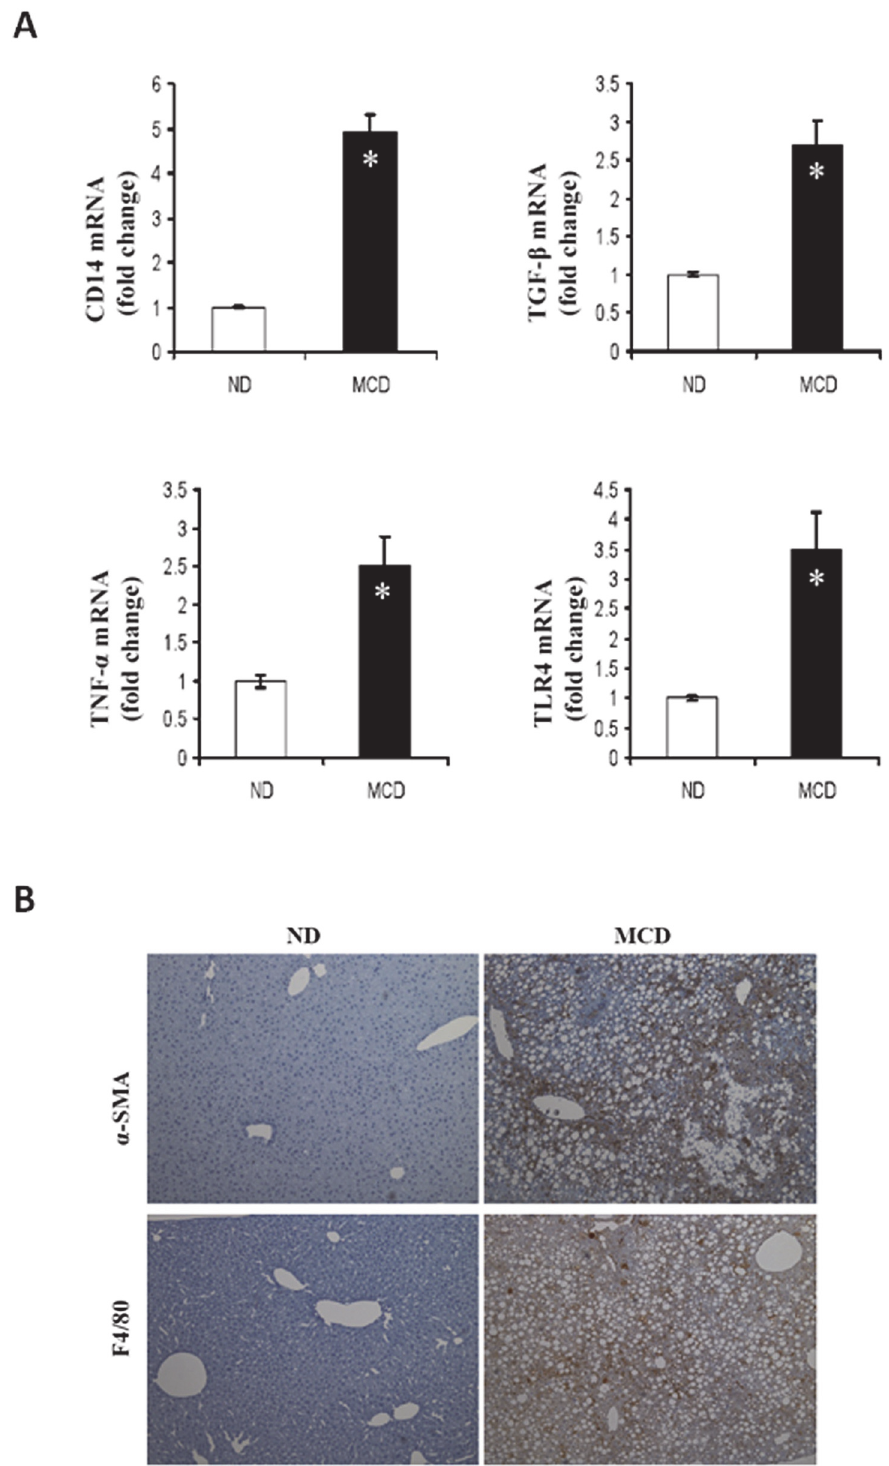
Fig 2. Expression levels of proteins functioning in the development of steatosis and steatohepatitis. Liver tissue extracts prepared from mice fed ND or MCD. (A) Hepatic levels of CD14 , TNF- α , TGF β 1 and TLR4 mRNA were measured by qRT-PCR. Genes were normalized to GAPDH RNA as an internal standard, and data are shown as fold increase. * P < 0.05. (B) Representative photomicrographs of α -SMA and F4/80 immunostaining in the liver of ND, MCD fed